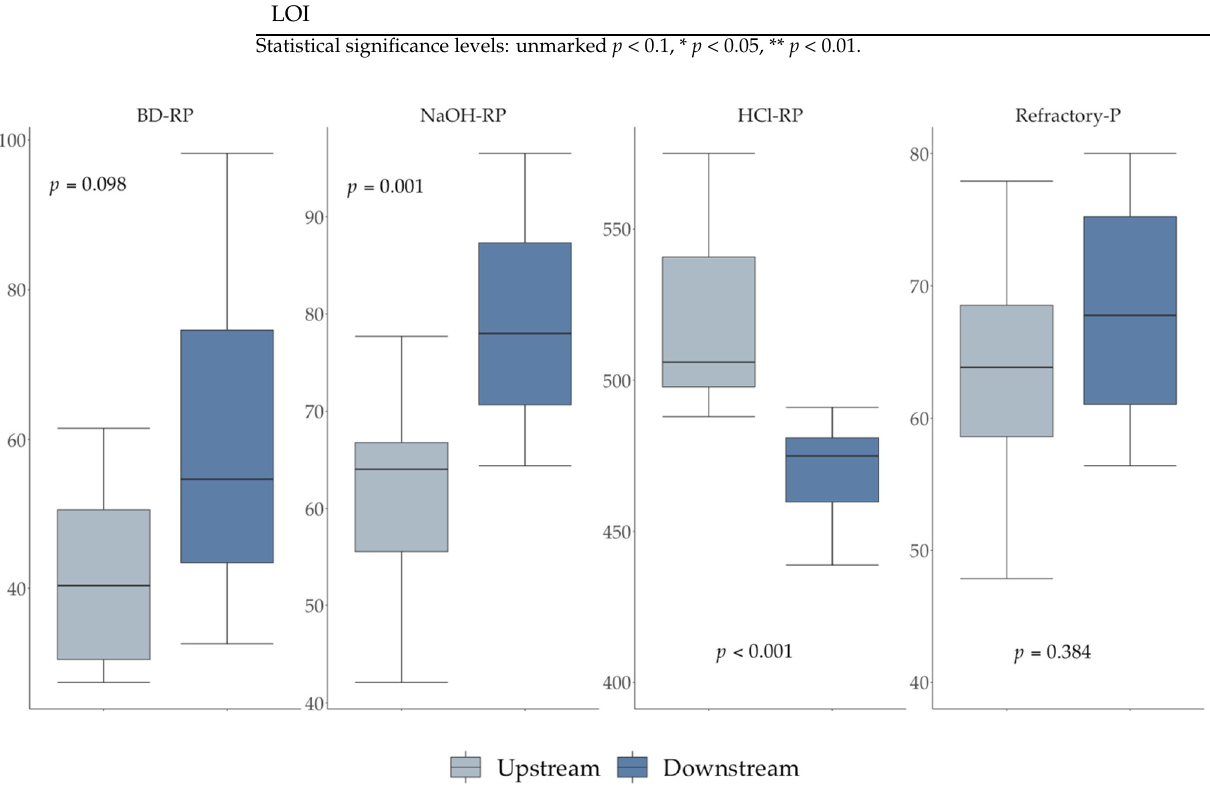
(S4, S5, S6; n = 12) sites. The p -values from the Wilcoxon signed-rank test are provided. Horizontal lines indicate the median,